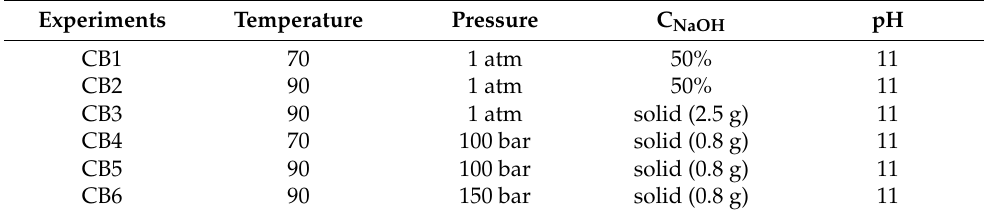
Table 3. Experimental conditions of the mineral carbonation